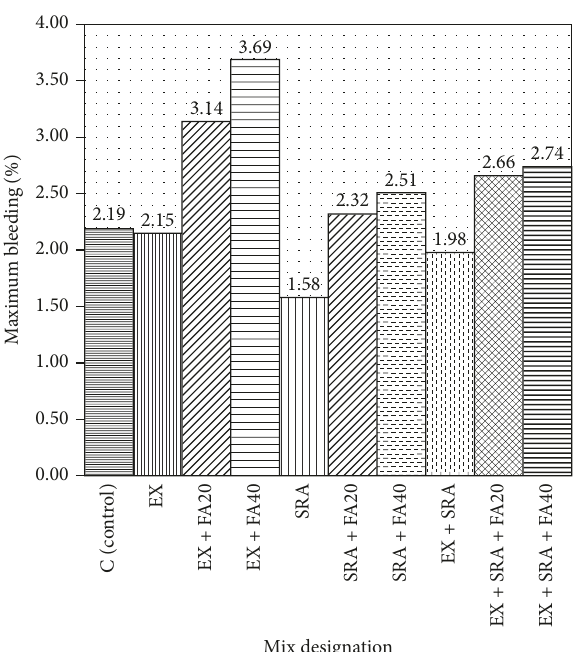
Figure 3: Bleeding of mortar mixed with EX, SRA, and FA.